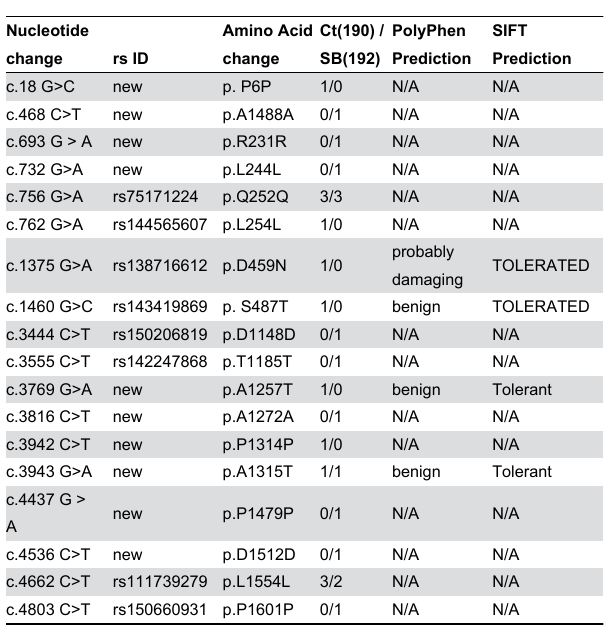
Table 2. Rare variants (<1%) in the open reading frame of SCRIB that are detected in NTD patients and controls or silent, or recorded in NCBI database.